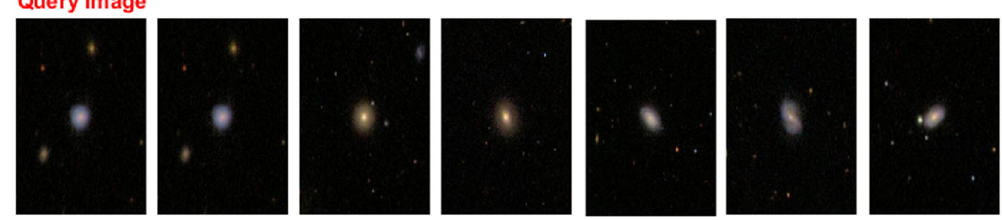
Figure 4. Galaxy image retrieval for an irregular galaxy 29 .